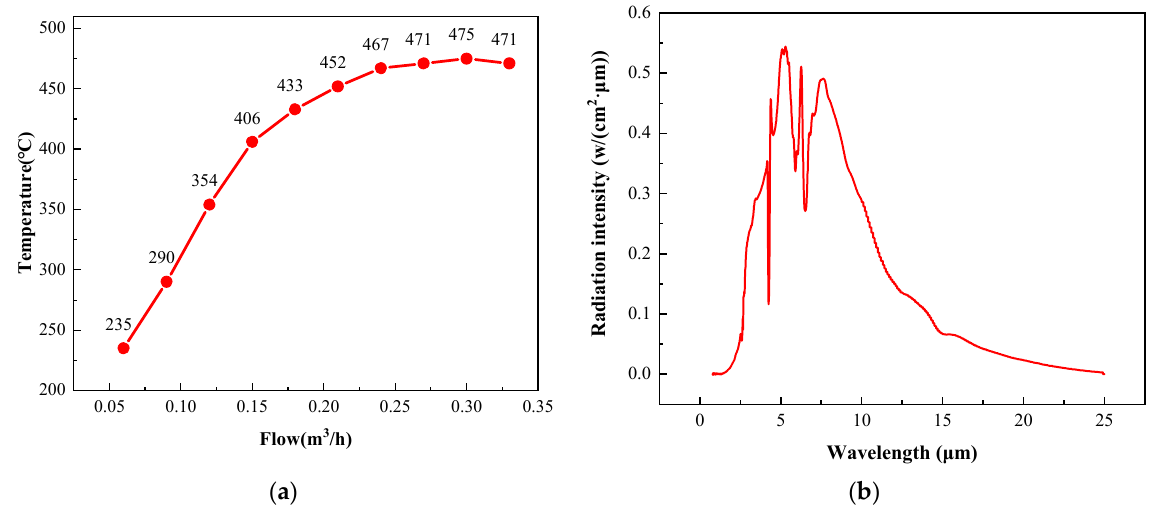
Figure 6. ( a ) Relationship between the surface temperature of the radiant panel and the gas intake. ( b ) The catalytic infrared radiation intensity of the radiant panel.